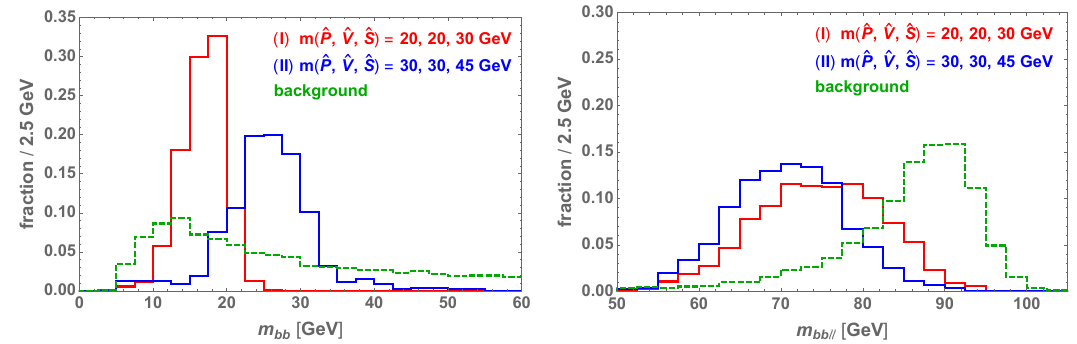
Figure 4 . Normalized distributions of the b (cid:22) b invariant mass ( left ) and total invariant mass of the b (cid:22) b‘‘ system ( right ) for the Z ! ^ P ^ S ! b (cid:22) b‘‘ + X signal and SM background at a Z factory, after the basic selection of eq.